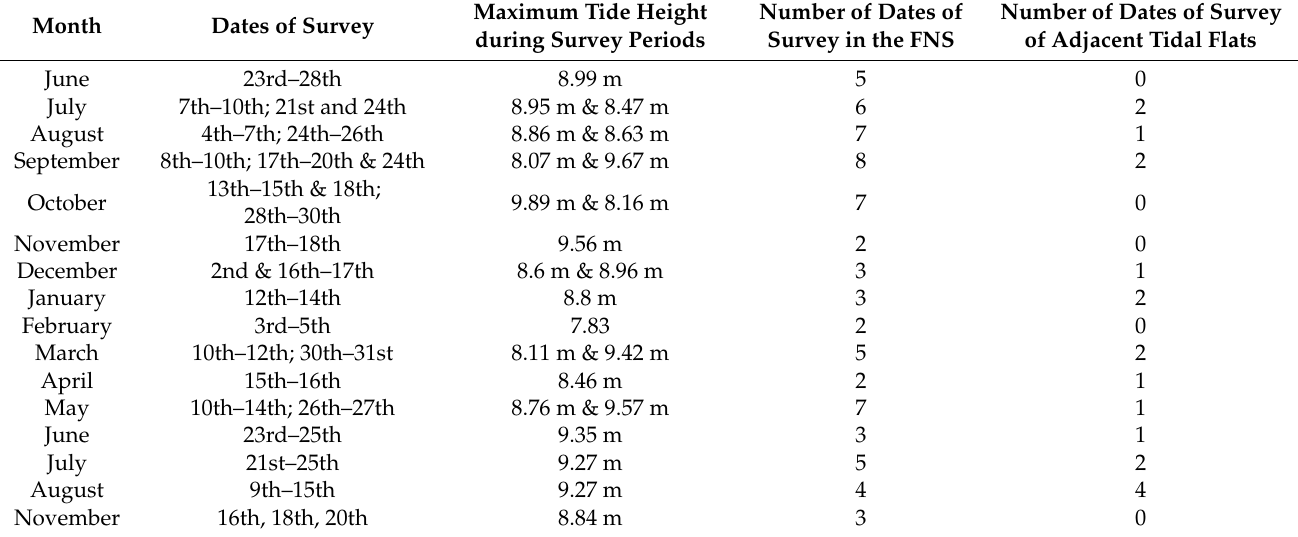
Table 1. Dates of the main surveys at the Hwaseong Wetlands FNS and adjacent Maehwari and/or Hwaseong Seokcheonri Tidal Flats in 2020 and 2021, with maximum tide heights (for the nearby Pyeongtaek Port) in each of the 23 survey